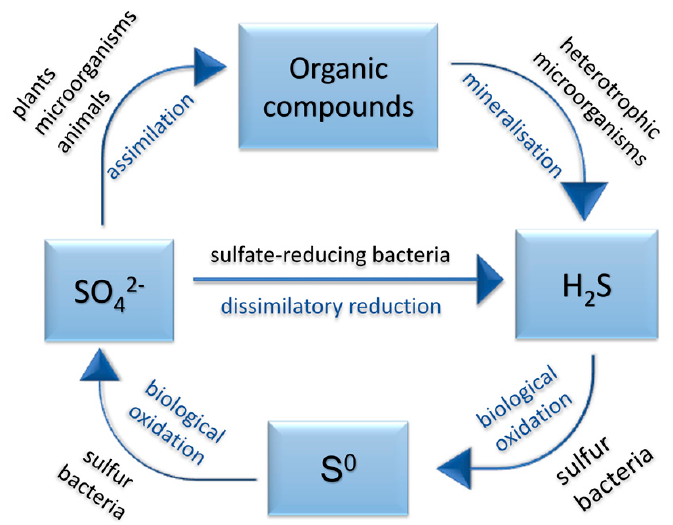
Figure 3. Scheme of the microbial sulfur cycle (modified from Tang et al. [29]).